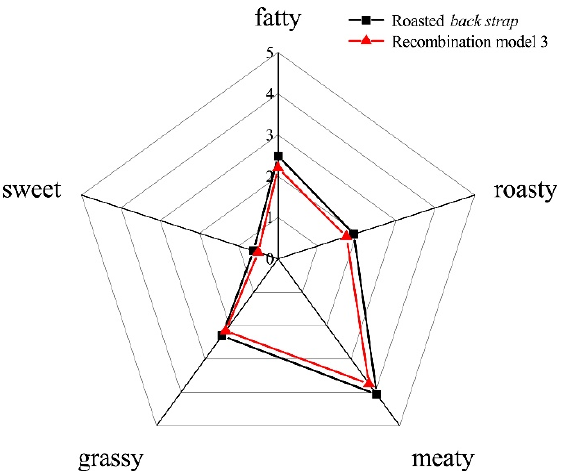
Figure 1. Aroma profiles of roasted mutton compared with the aroma recombination model 3.